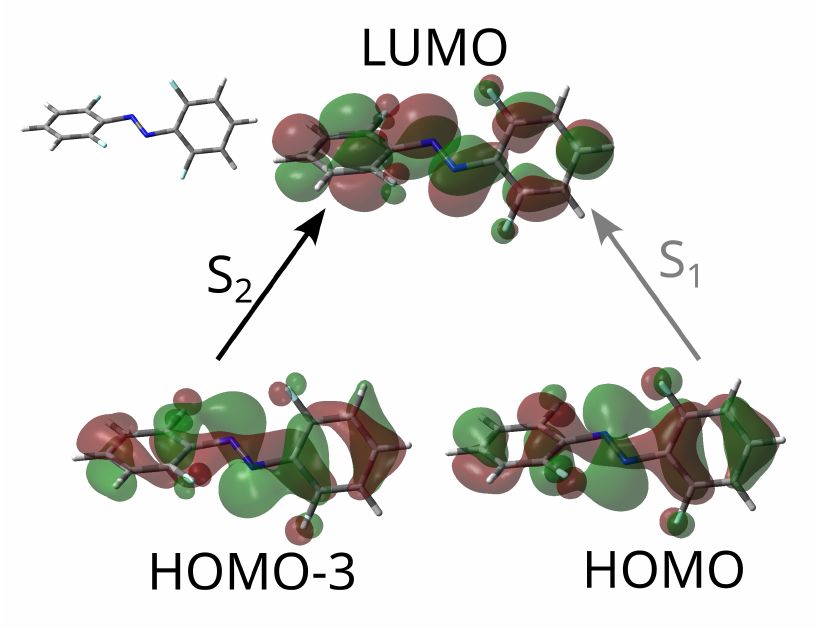
Figure 2. Molecular orbitals involved in the excitations giving rise to excited singlet states S 1 and S 2 in the case of the substituted azobenzene with X=F. The different intensities of the arrows indicate the magnitude of the transition probabilities from the ground state by means of electromagnetic